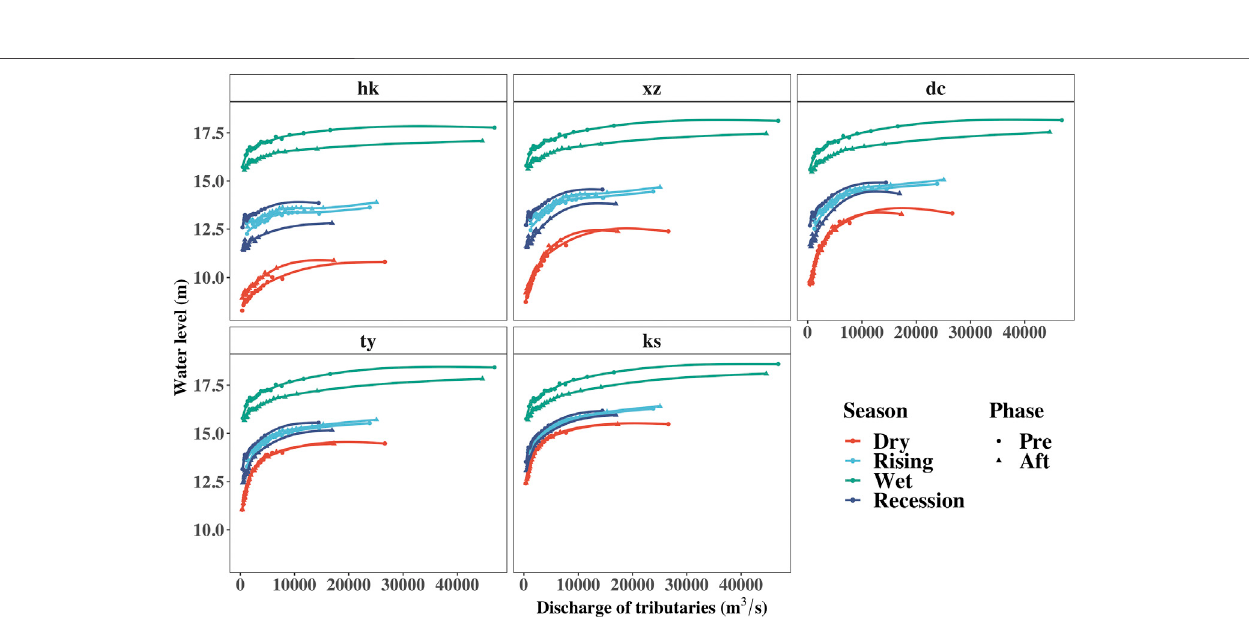
FIGURE 6 | Partial dependence plots of the discharge of the local tributaries and predicted water level.